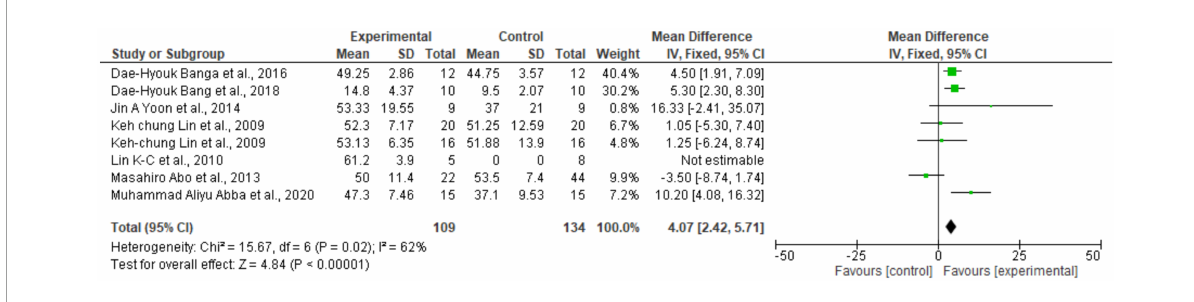
FIGURE2 Forest Plot of the manual function assessed by the Fugl Meyer test. SD, standard deviation; CI, confidence interval.